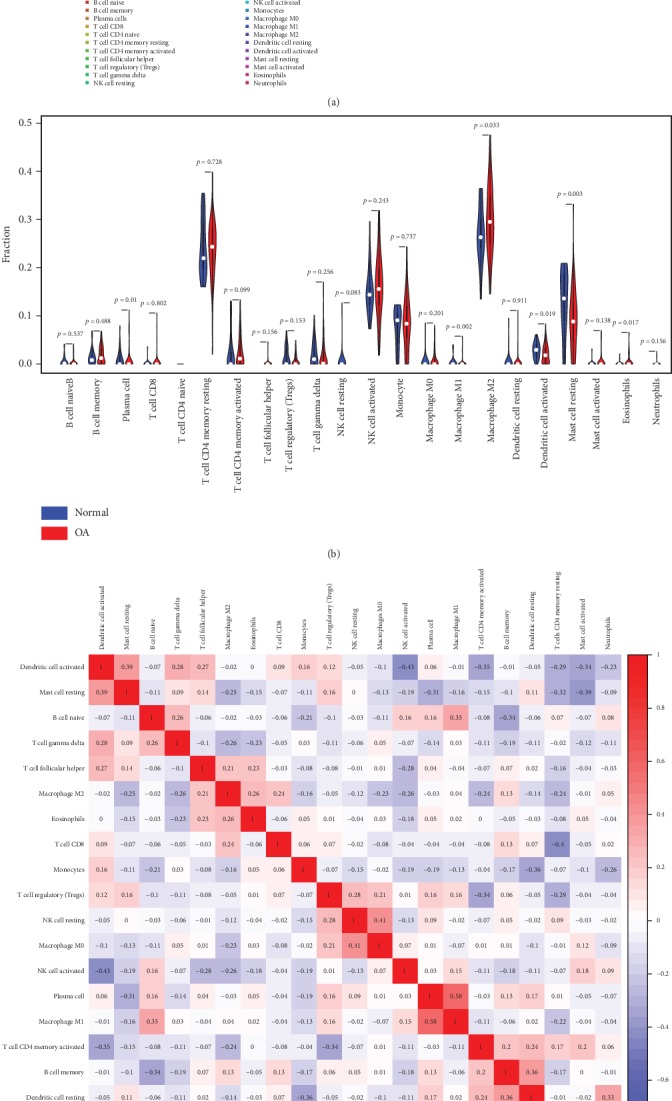
The landscape of immune infiltration in osteoarthritis in synovial tissue. (a) The composition of immune cells for each sample. Total: the average composition of immune cells. (b) The difference of immune infiltration between osteoarthritic tissue and normal tissue. (c) Correlation matrix of all 22 immune cell proportions. (d) Heat map of the 22 immune cell proportions. OA: osteoarthritis.